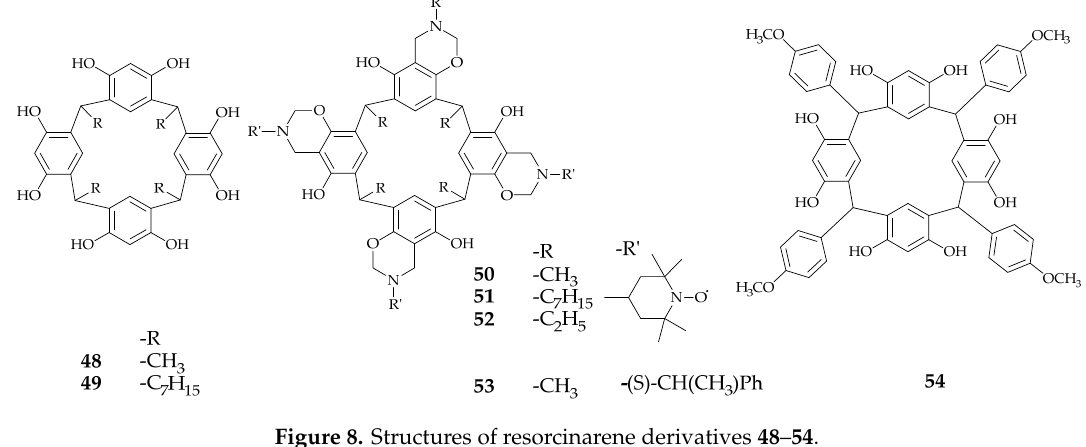
Antioxidants 2020 , 9 , x FOR PEER REVIEW 8 of 21 Figure 8. Structures of resorcinarene derivatives 48 – 54 . Figure 8. Structures of resorcinarene derivatives 48 – 54 .